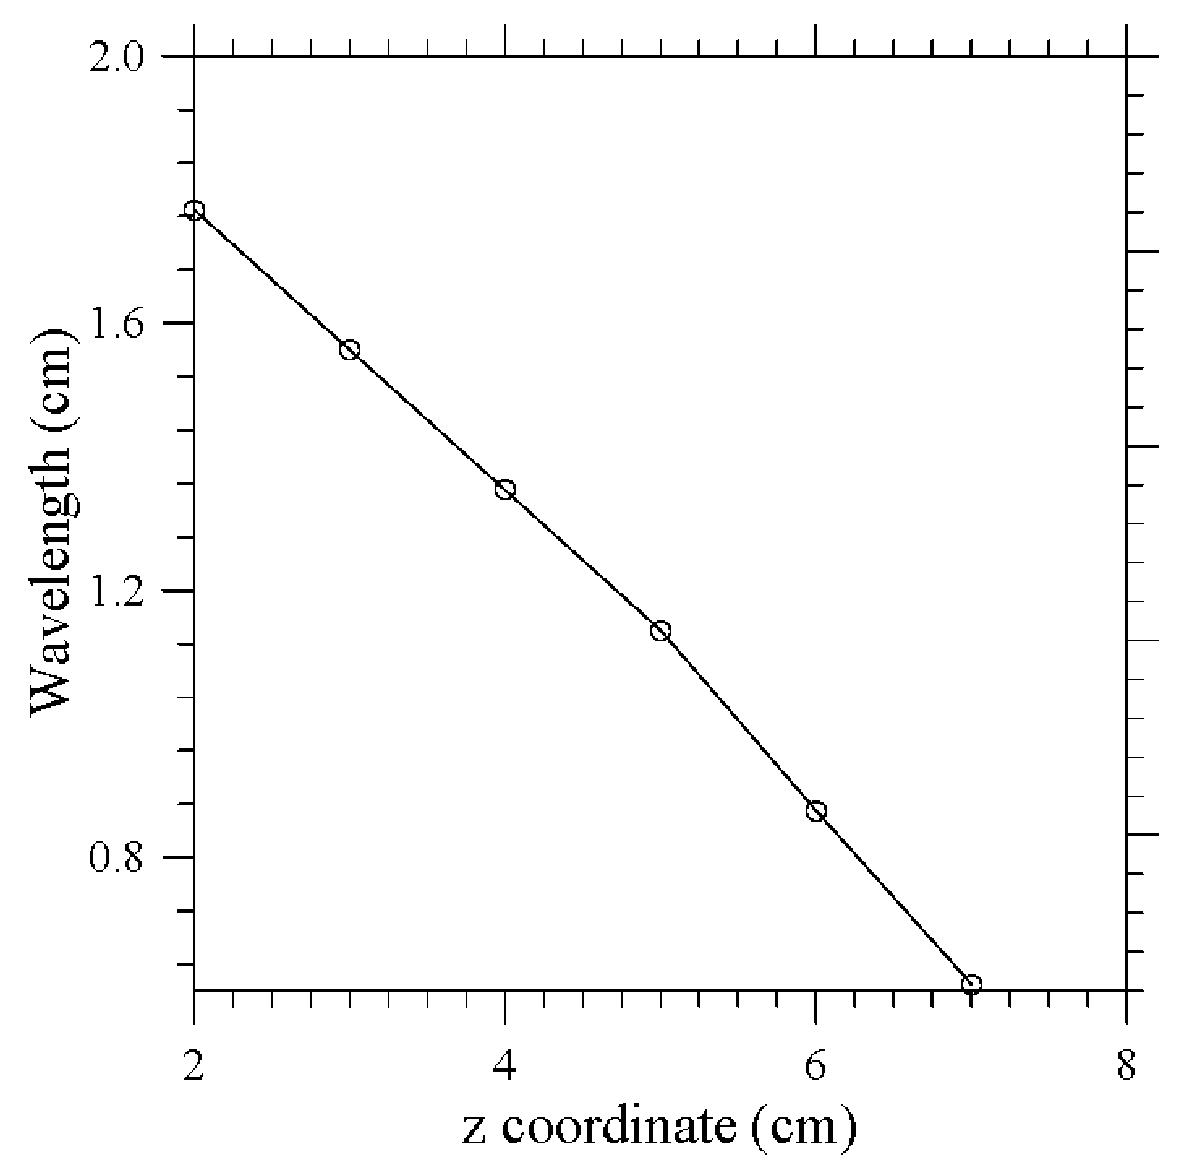
Figure 7. Transverse roll extension as a function of the longitudinal direction z for ∆ T = 27°C (square container, A = 16, d = 0.50 cm, Bo dyn ∼ = 0.86, ϑ ∼ = 3.5°).